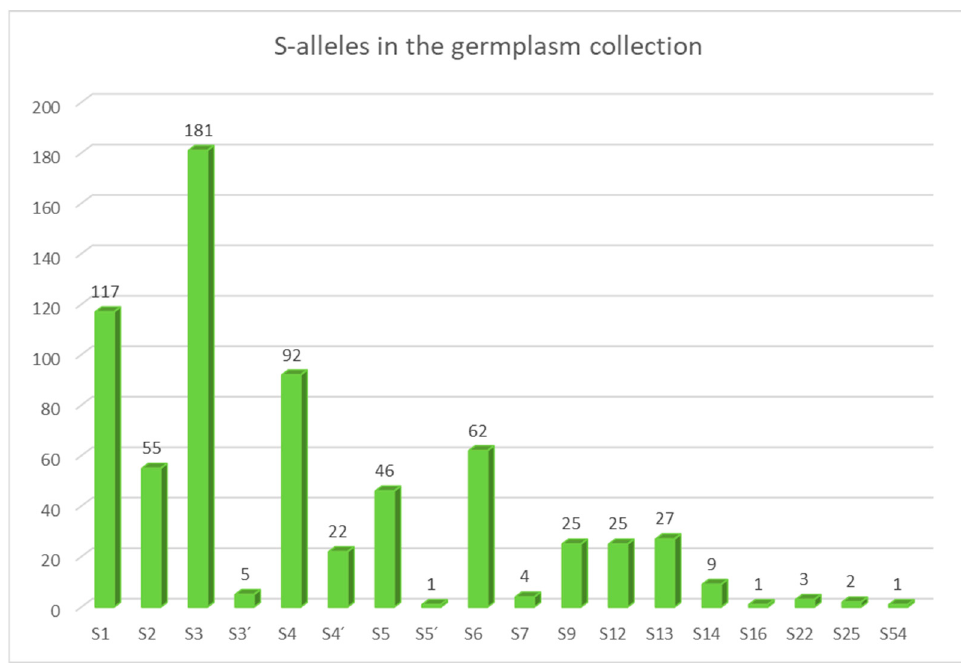
Figure 7. Frequency of individual S-alleles found in the germplasm collection.